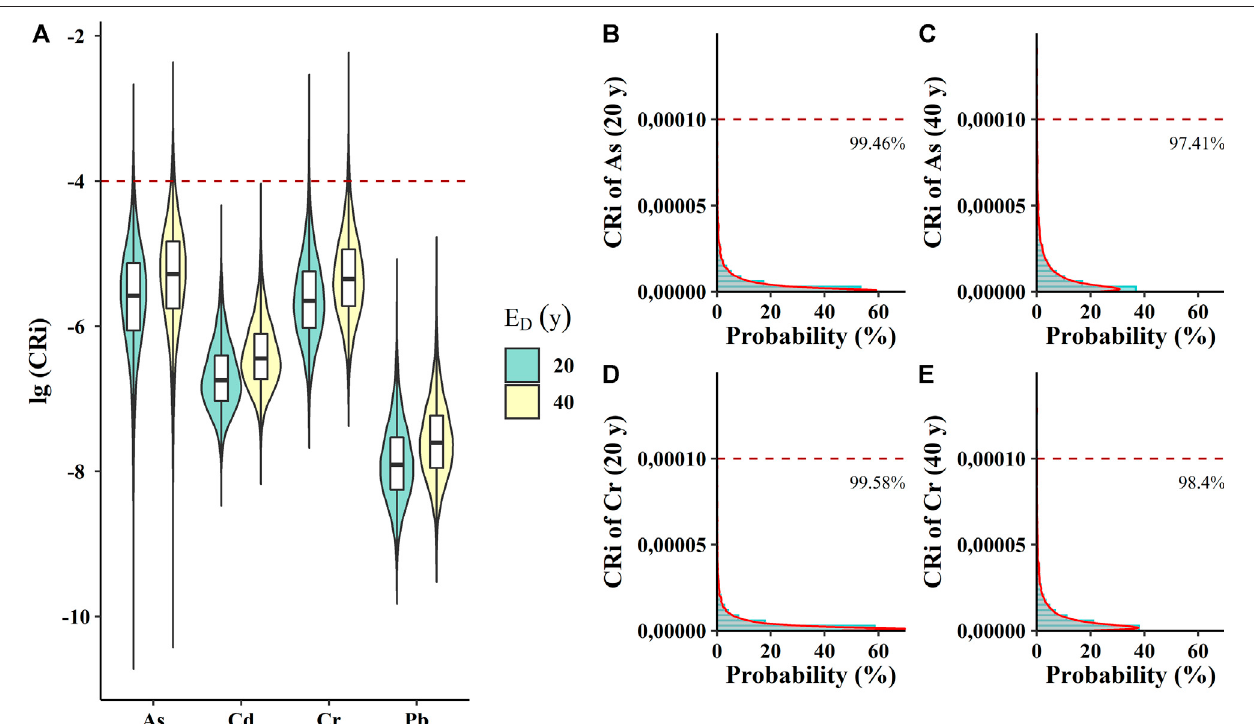
FIGURE 3 | Estimated carcinogenic risks (CR i ) of selected heavy metals in Pheretima . (A) Violin plot showing log 10 (CR i ) values of eight heavy metals in Pheretima . (B,C) TheprobabilitydistributionofpotentialhealthriskofAsduringtheexposureof20and40 years. (D,E) TheprobabilitydistributionofpotentialhealthriskofCrduring the exposure of 20 and 40 years. The red dashed line the acceptable limit of CR i.